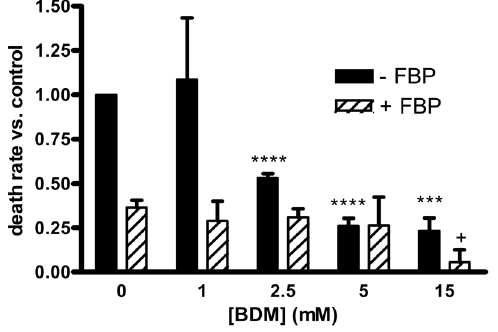
Figure 5. Effects of 2,3-butanedione monoxime on preserva- tion. Myocytes were incubated with the indicated concentrations of BDM with or without 5 mM FBP. Results are means of 3 determinations. Statistically significant by paired t-tests: ***, p , 0.005 vs. control; ****, p , 0.002 vs. control; + , p , 0.05 vs. FBP alone.